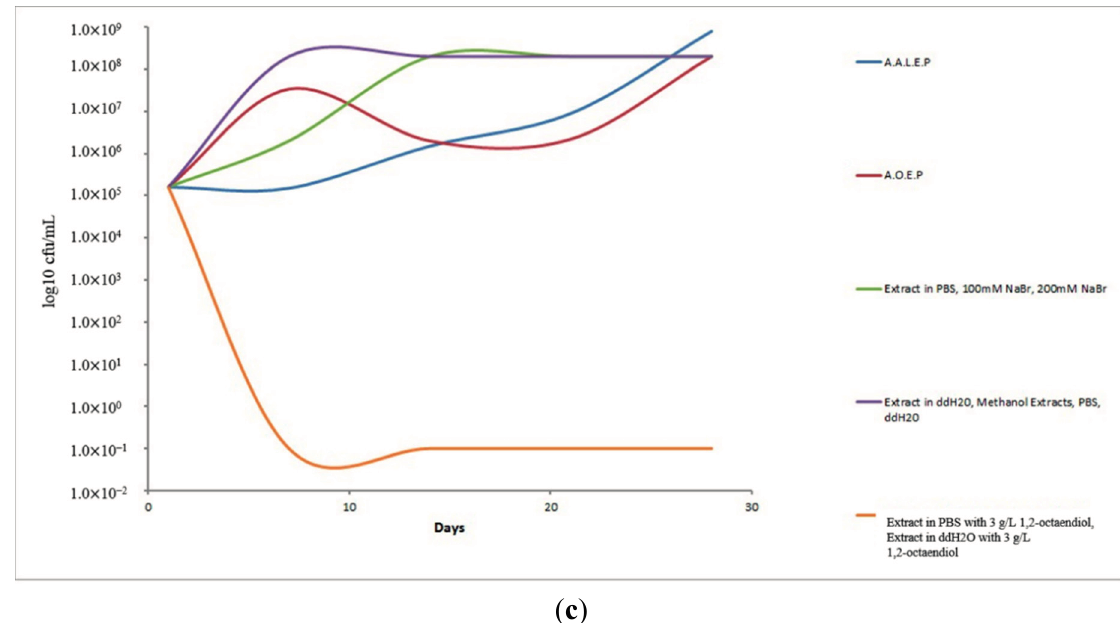
Figure 1. Antibacterial effects of Cornus mas L. extracts against ( a ) S. aureus ; ( b )